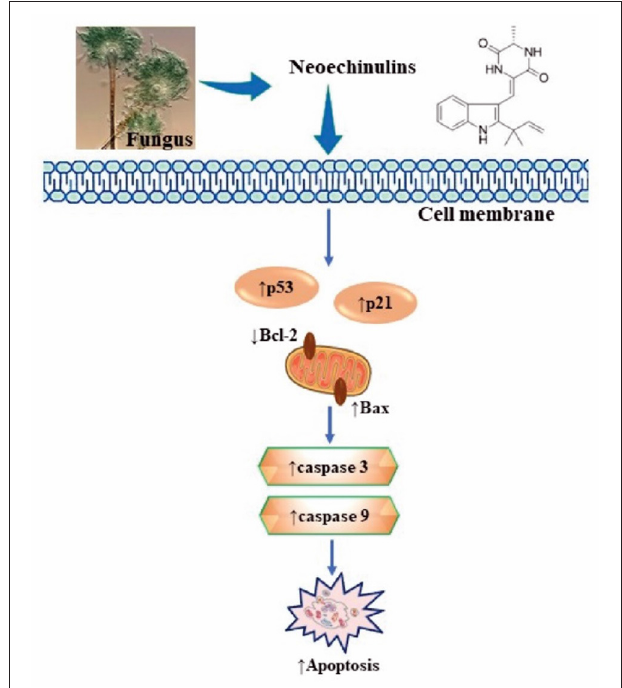
FIGURE 2 | Summarised scheme of potential cytotoxic mechanisms of neochinulins to induce apoptosis in cancer cells. p53, p21, cellular tumour antigen; Bcl-2, B-cell lymphoma 2; Bax, Bcl-2-associated X